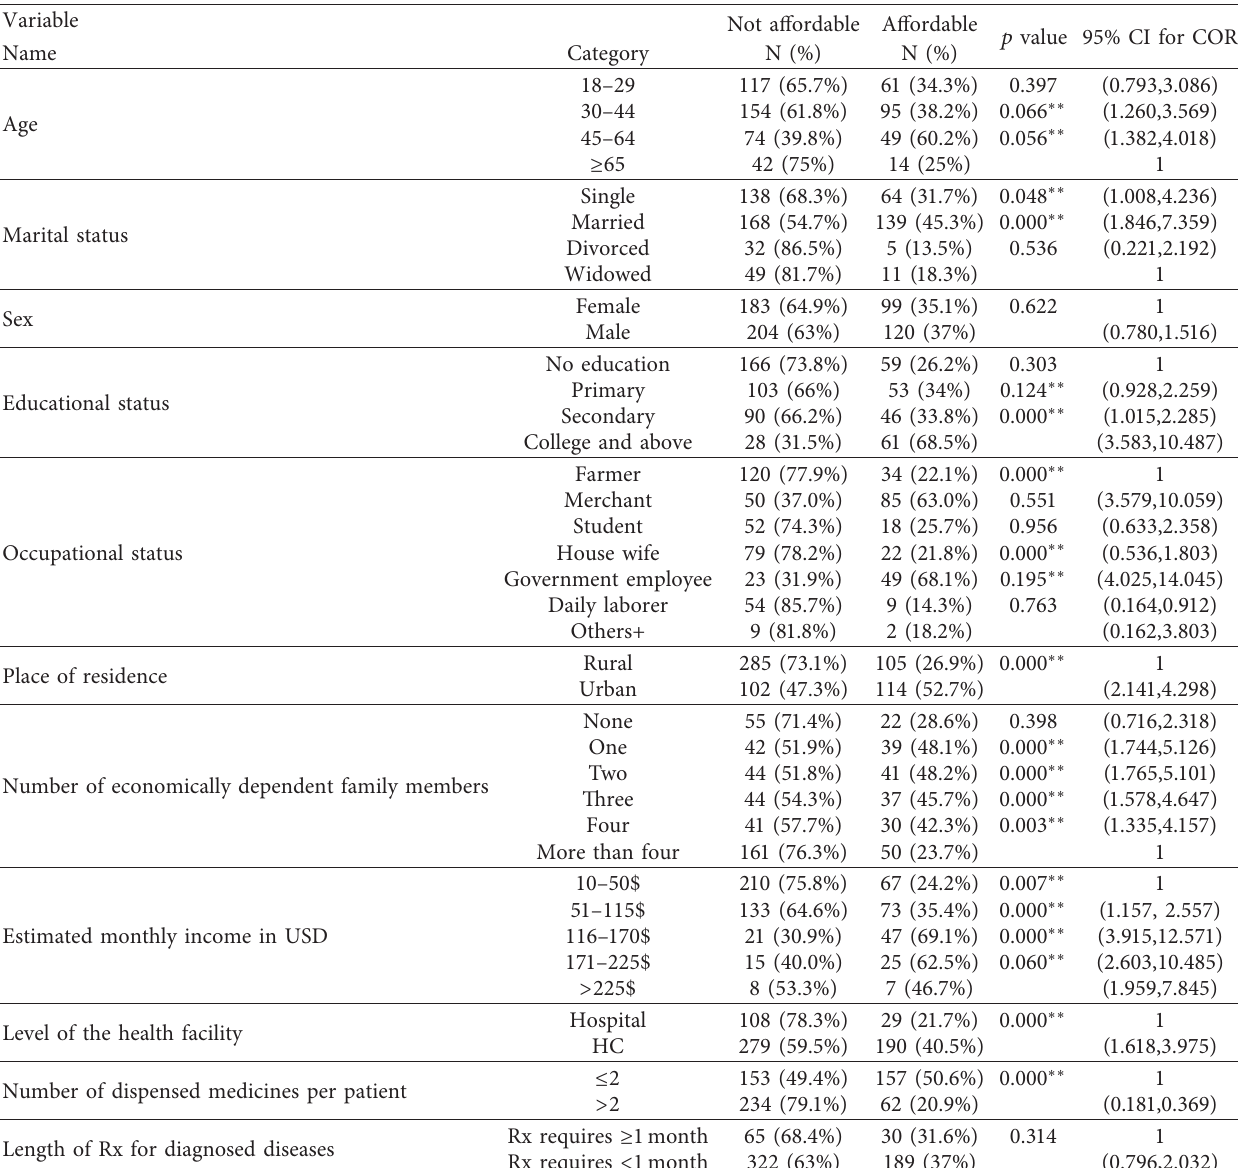
Table 3: Bivariate analysis of factors associated with perceived affordability of essential medicines in public health facilities of the Jimma Zone, Southwest